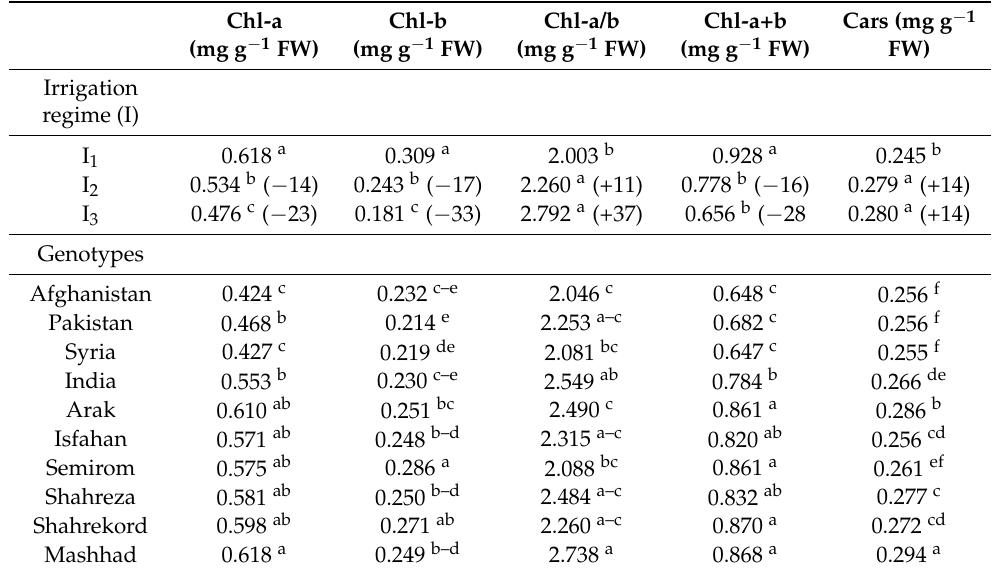
Table 4. Mean comparison of the effect of irrigation regime (I) and genotype (G) on Chl-a, Chl-a, Chl-a/b, Chl-a+b, and Cars of black cumin in a two-year period (2017–2018).